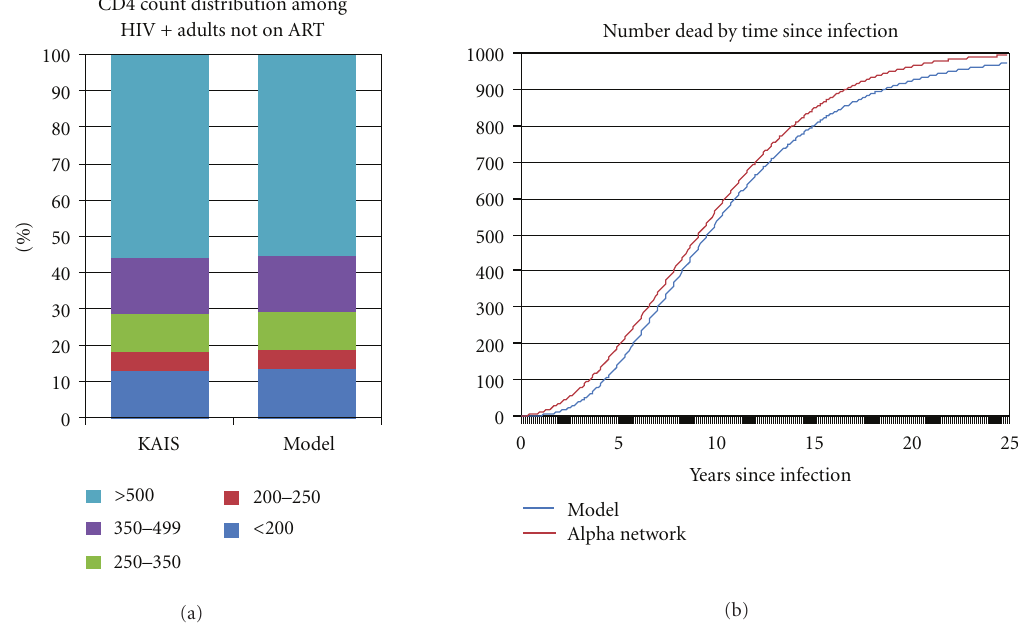
Figure 3: Model results compared to CD4 count distributions in Kenya in 2007 and progression from infection to death compared to ALPHA network